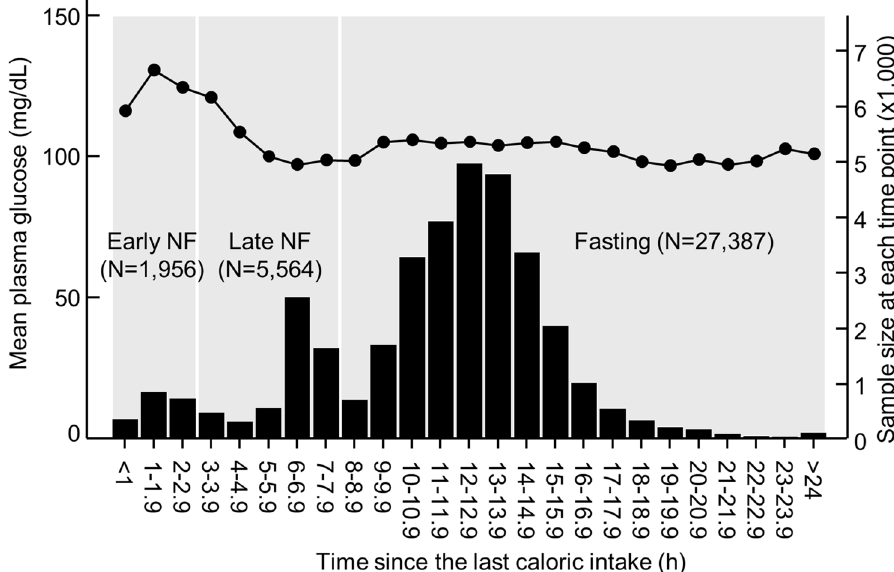
Figure 1. Mean plasma glucose concentrations at each hour since the last caloric intake. The line graph represents plasma glucose concentrations, and the histogram represents sample size at each time point. The time since the last caloric intake was divided into three periods: 0–2.9 h (early non-fasting), 3.0–7.9 h (late non- fasting), and ≥ 8.0 h (fasting). NF, non-fasting.